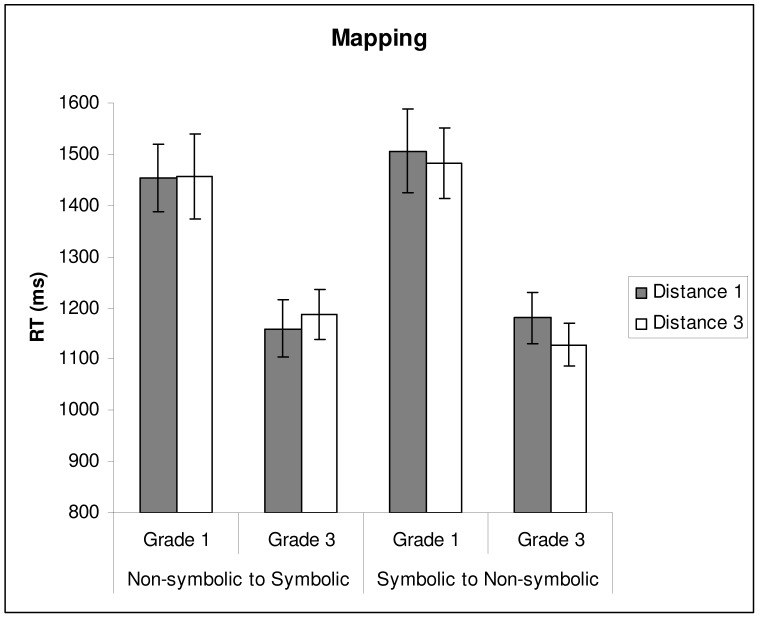
Mean reaction time (based on correct responses only) on the mapping tasks as a function of grade and distance.Error bars depict 1SE of the mean.